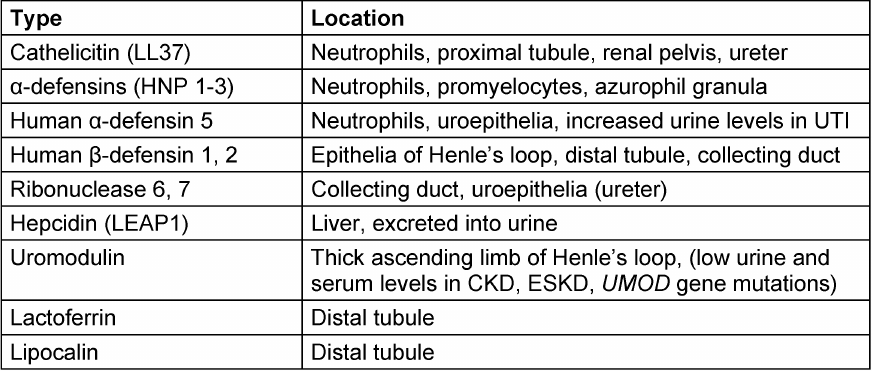
Table 4: Selected natural (intrinsic) defensins involved to overcome